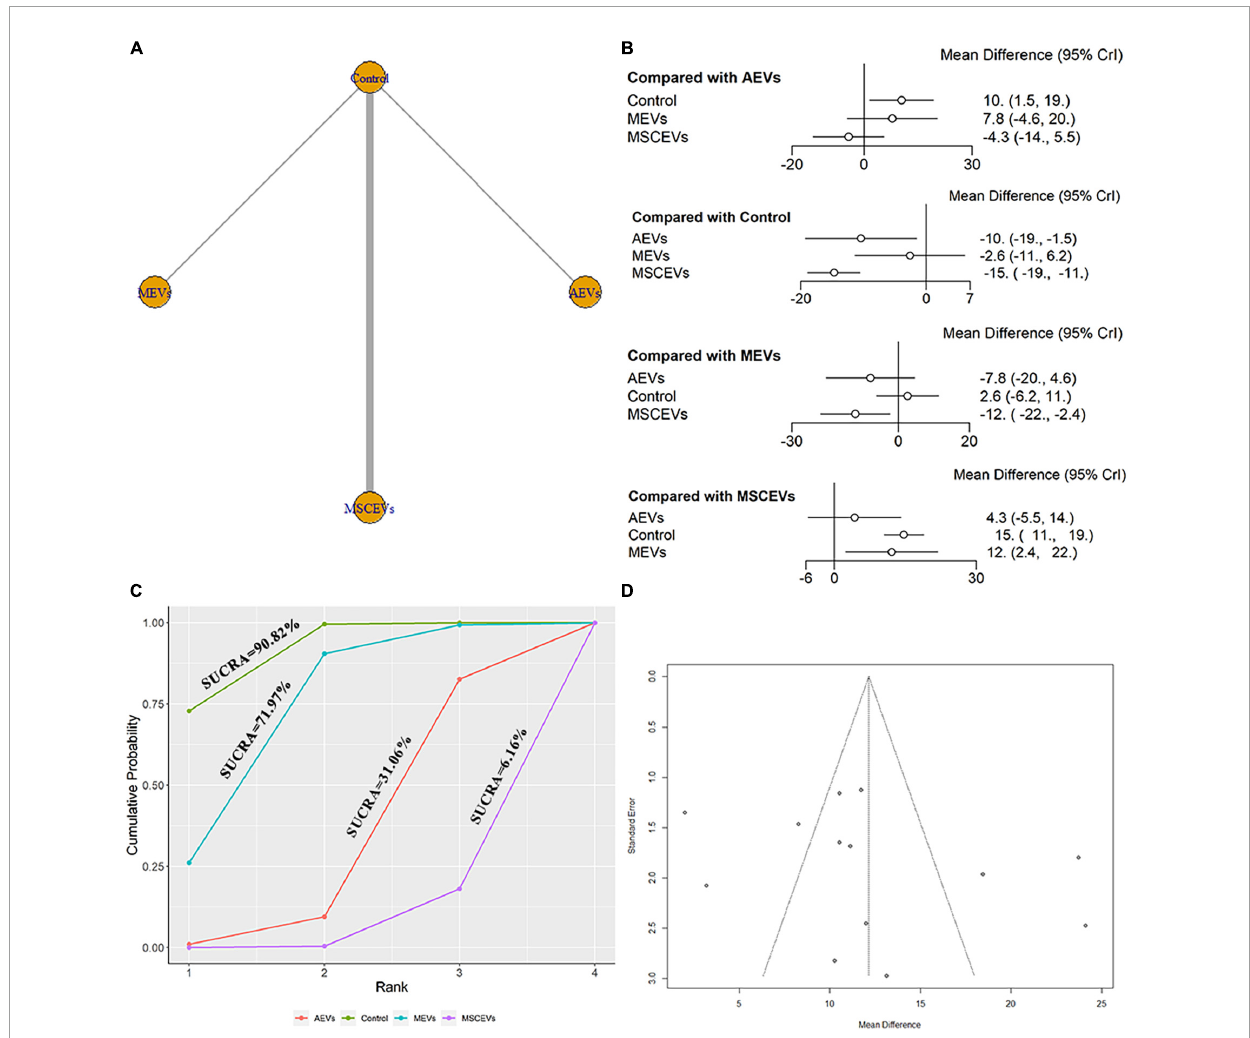
FIGURE8 Comparison of the efficacy of extracellular vesicles (EVs) from different cell sources in escape latency of Morris Water Maze (MWM). (A) Network plot; (B) Forest plot; (C) Surface under the cumulative ranking curves (SUCRA); (D) Funnel plot. The dotted lines represent 95% confidence interval (95% CI). AEVs, astrocyte-derived extracellular vesicles; MEVs, microglia-derived extracellular vesicles; MSCEVs, mesenchymal stem cell-derived extracellular vesicles; NSCEVs, neural stem cell-derived extracellular